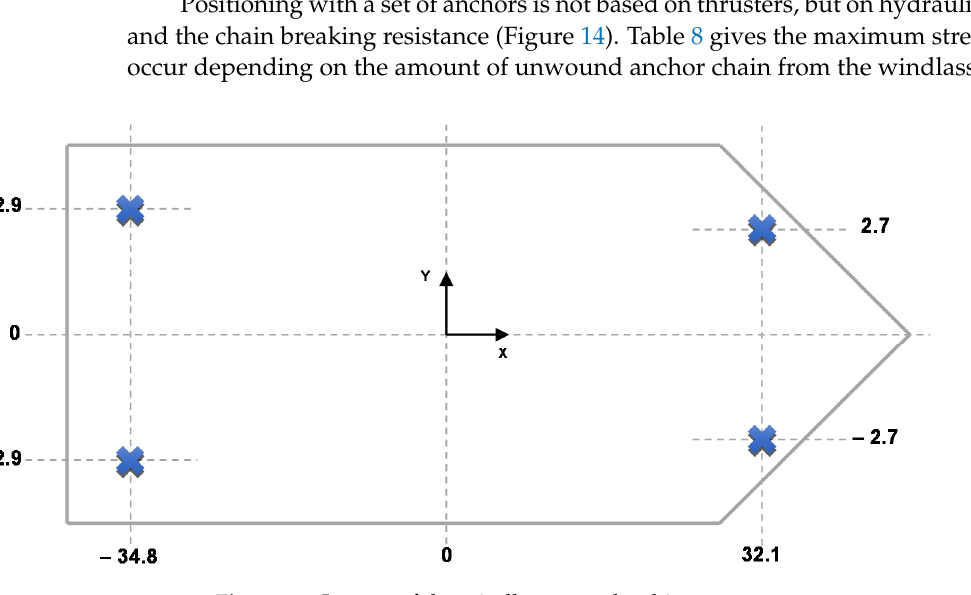
Table 8. Maximum values of the tension of the anchor chains depending on the length of the un- wound chain.